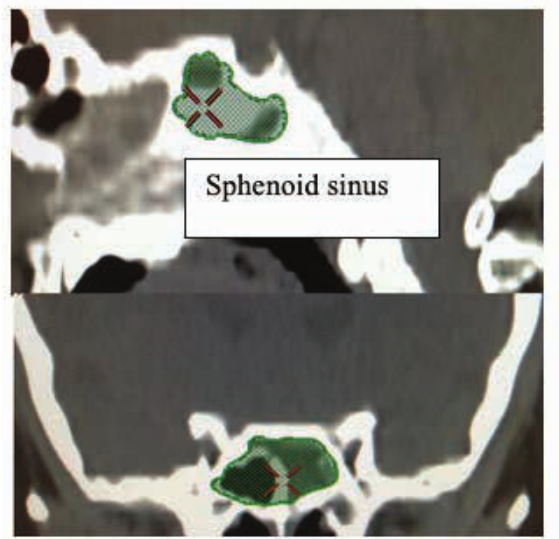
Figure 4: Images relevant to the volume measurement of the sphe- noid sinus on Advantage Workstation 4.4.